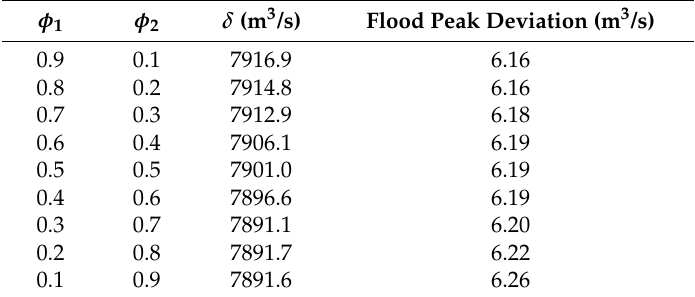
Table 5. Multi-objective weight coefficient